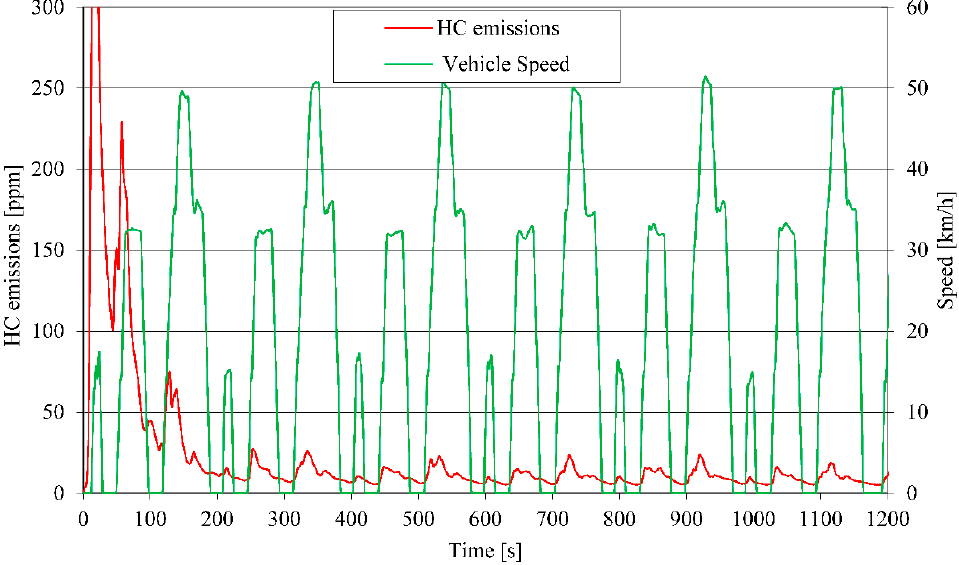
Figure 3. HC instantaneous emissions and speed–time profile measured during the UDC driving cycle.